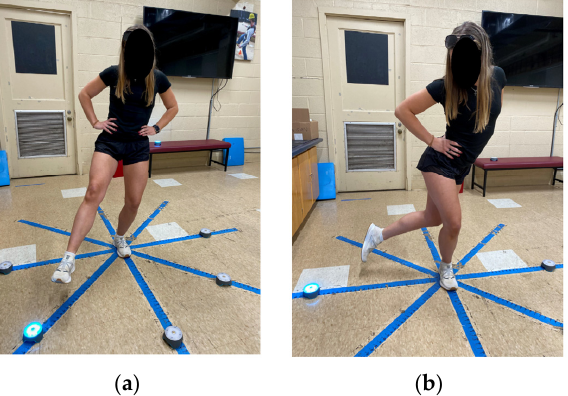
Figure 1. Participant performing SEBT with the left leg stance condition ( a ) and the right leg stance condition ( b ), while simultaneously activating the BlazePod during the mSEBT cognitive-motor